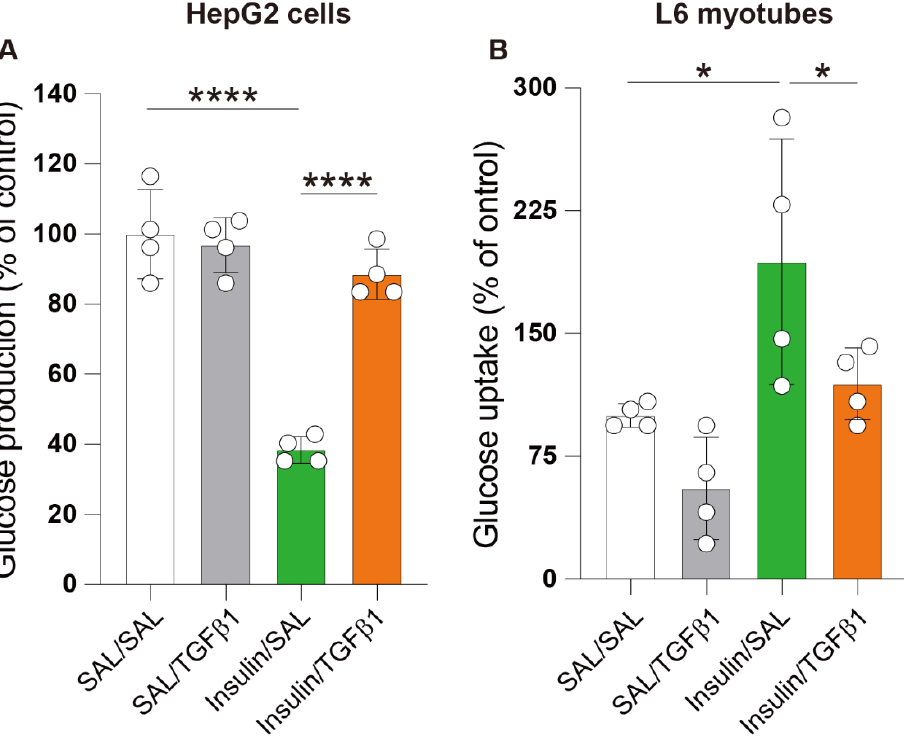
Figure 5. Transforming growth factor β 1 worsens insulin sensitivity in target cells. HepG2 ( A ) and L6 myoblasts ( B ) were cultured in the presence of insulin alone (200 nM) or in the presence of both insulin and transforming growth factor β 1 alone (20 ng/mL) for 4 h before measuring the medium glucose levels. Data are expressed as mean ± S.D. n = 4 per group. Statistical analysis by ANOVA with Newman – Keuls ’ test. * p < 0.05; **** p < 0.0001.